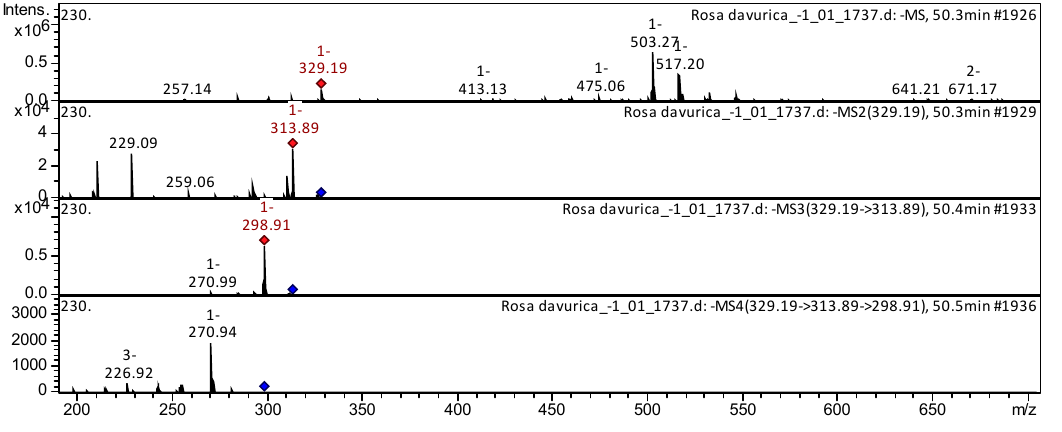
Figure 4. CID-spectrum of Tricin from extracts of R. davurica , m / z 329.19. The [M – H] – ion produced three fragment ions at m / z 313, m / z 259, and m / z 229 (Figure 4). The fragment ion with m / z 313 produced two daughter ions at m / z 298 and m / z 271. The fragment ion with m / z 298 yielded two daughter ions at m / z 271 and m / z 227. It was identified in the bibliography in extracts of Triticum aestivum [22]; millet grains [23]; Sasa veitchii; Phyllostachys nigra [24].